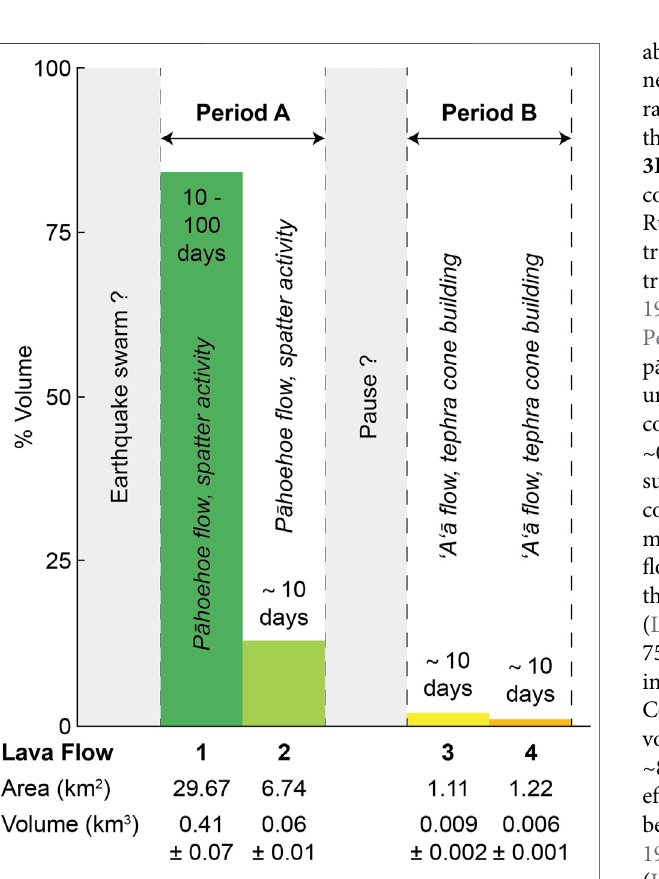
Frontiers in Earth Science |